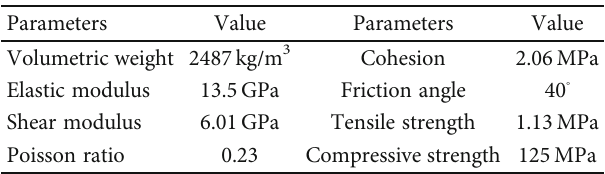
and the failure time t of the numerical model. a f Table 1: Macroscopic mechanical parameters of coal measure